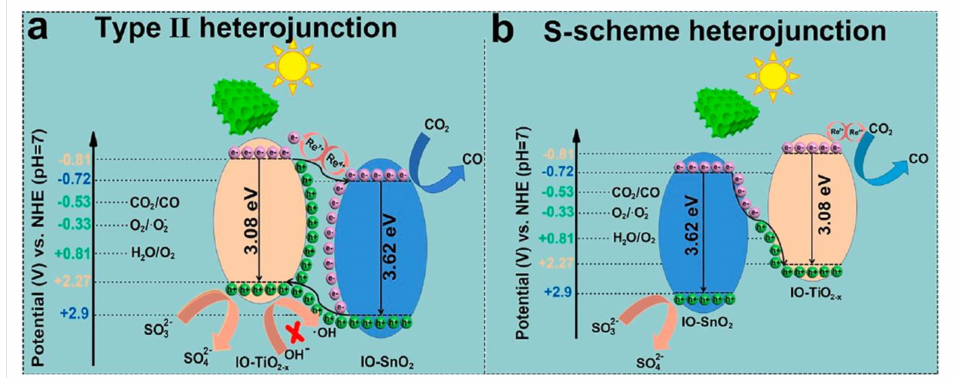
Figure 13. A representative scheme of electron transfer in the heterojunction (Re-IO-TiO 2–x /SnO 2 ) in the CO 2 photoreduction process. Adapted with permission from Reference [134]. Copyright 2021